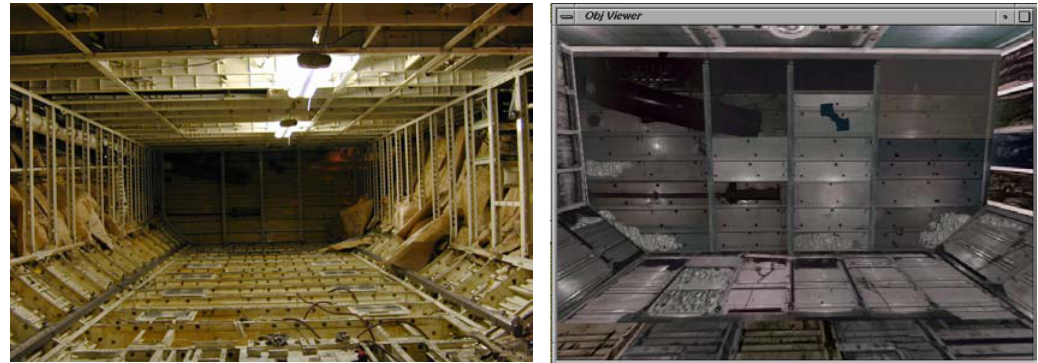
Figure 4. “Real (left) and VR (right) Aircraft Cargo bay”. Source: Own